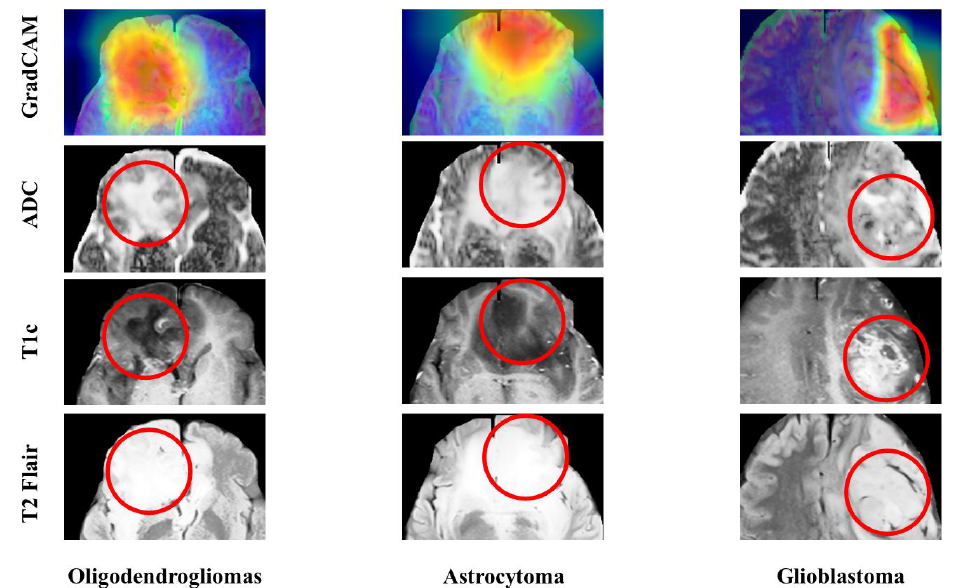
Figure 7. Visualization of imaging features and GradCAM analysis of the final 3-class model for predicting oligodendrogliomas, astrocytomas, and glioblastomas. The regions of red cycles represent the lesions. Colors nearer to red and blue indicate regions with higher and lower weights.